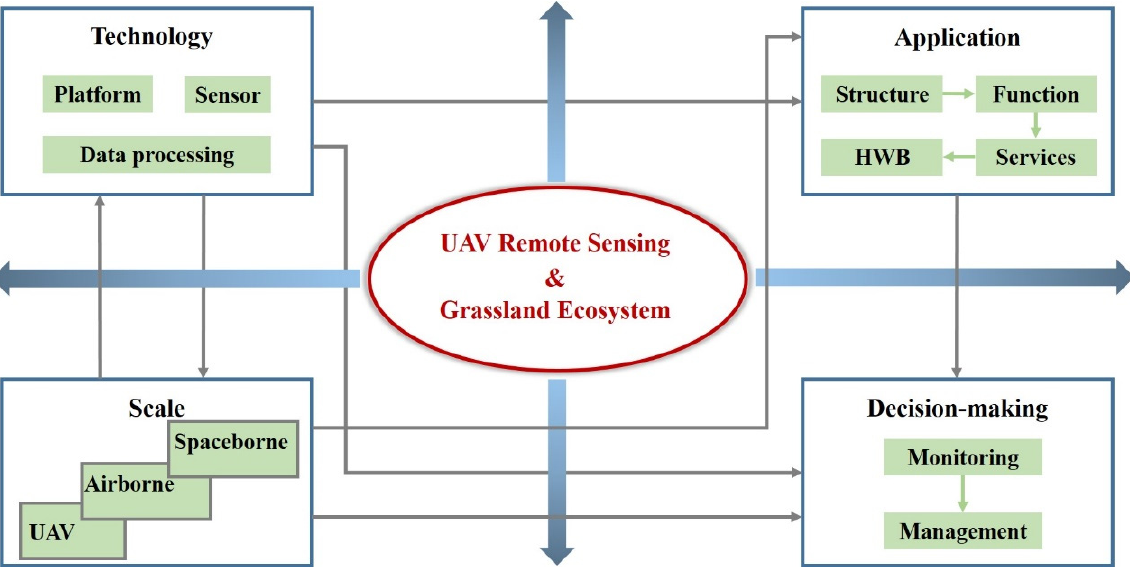
Figure 3. Future directions of unmanned aerial vehicle remote sensing in grassland ecosystem monitoring. HWB, human well-being.